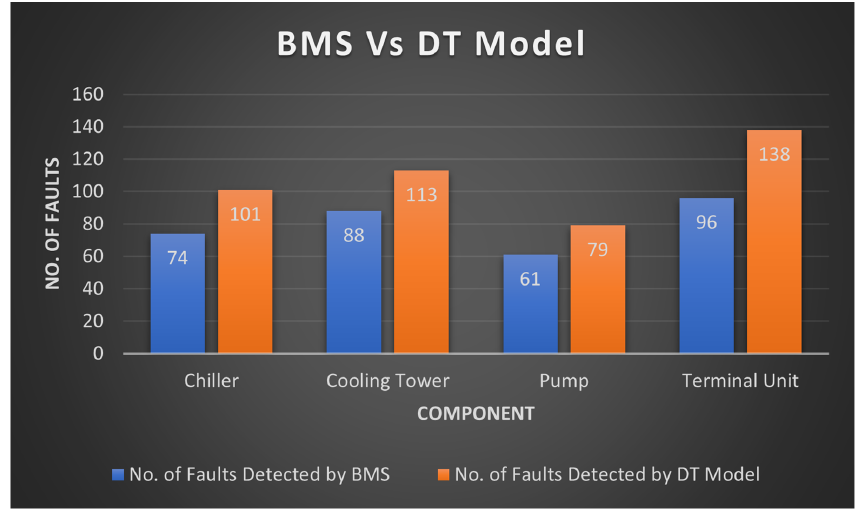
Figure 14. Comparison of Prediction Performance.